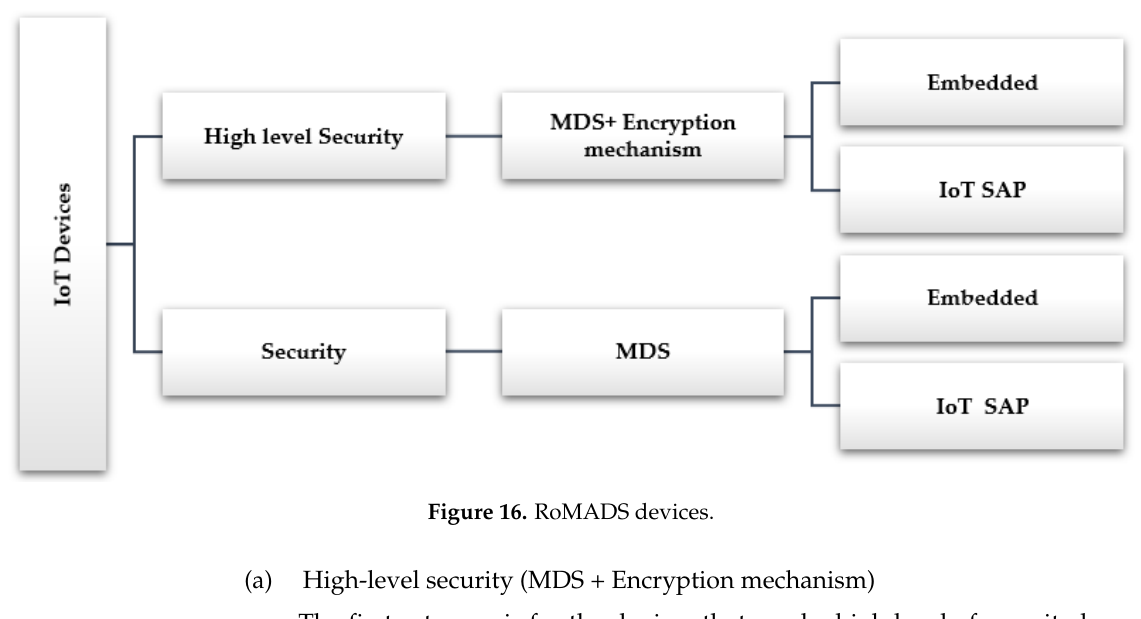
Figure 16. RoMADS devices.